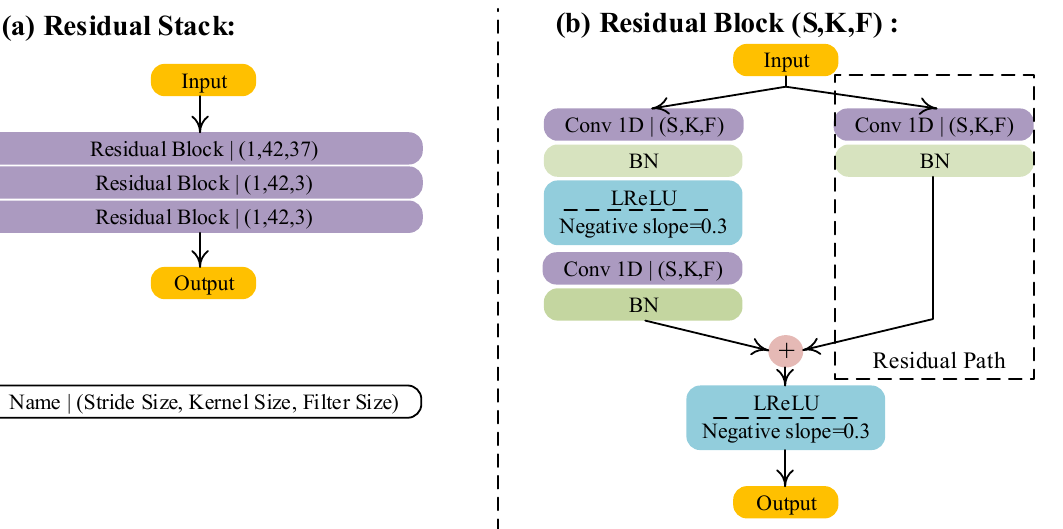
Figure 5. Structure of the residual stack and modified residual block. S, K, and F denote stride size, kernel size, and filter size, respectively. BN and LReLU are abbreviations of batch normalization and the Leaky Rectified Linear Unit, respectively. Conv 1D denotes the 1D convolution. The final step aims to further fuse concatenated feature maps. Due to the method of regression, the last residual block used in this step does not include the final activation function, and the filter size of the final residual block is 2. The output signals of this step are also 10 s but with a high sampling rate of 500 Hz.